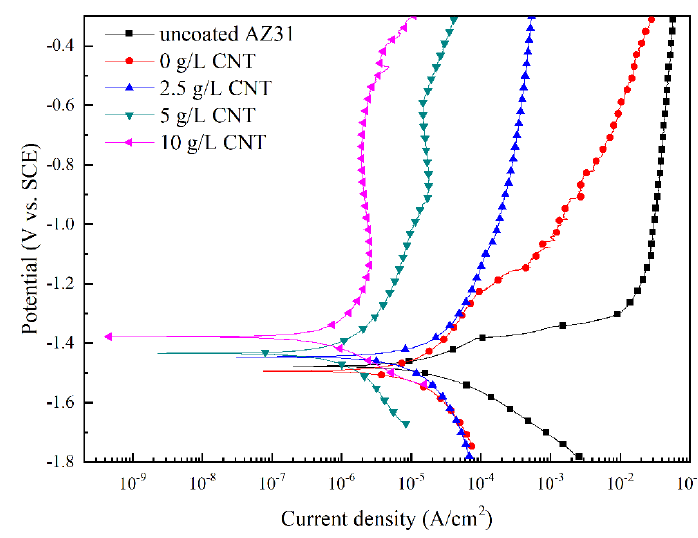
Figure 9. Potentiodynamic polarization curves of the PEO coatings formed in different CNT concentration of electrolytes. Table 2. Tafel analysis results of uncoated and PEO-coated samples in an electrolyte containing different concentration of CNT.